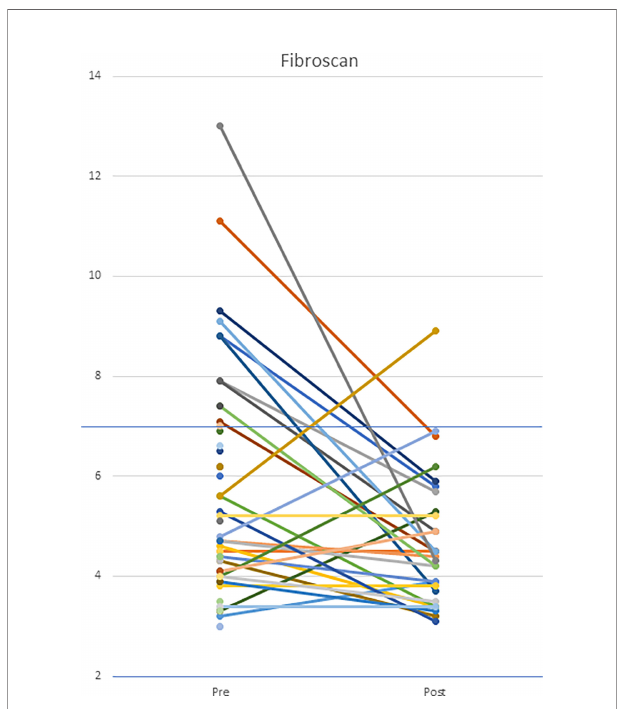
FIGURE 14 | Hepatic transient elastography in patients both pre- and post- initiation of anti-TNF therapy. Patients underwent transient elastography both pre- and post-anti-TNF initiation. Upper limit of normal is de fi ned as 7 kPa. The cohort had a statistically signi fi cant decrease in transient elastography scores